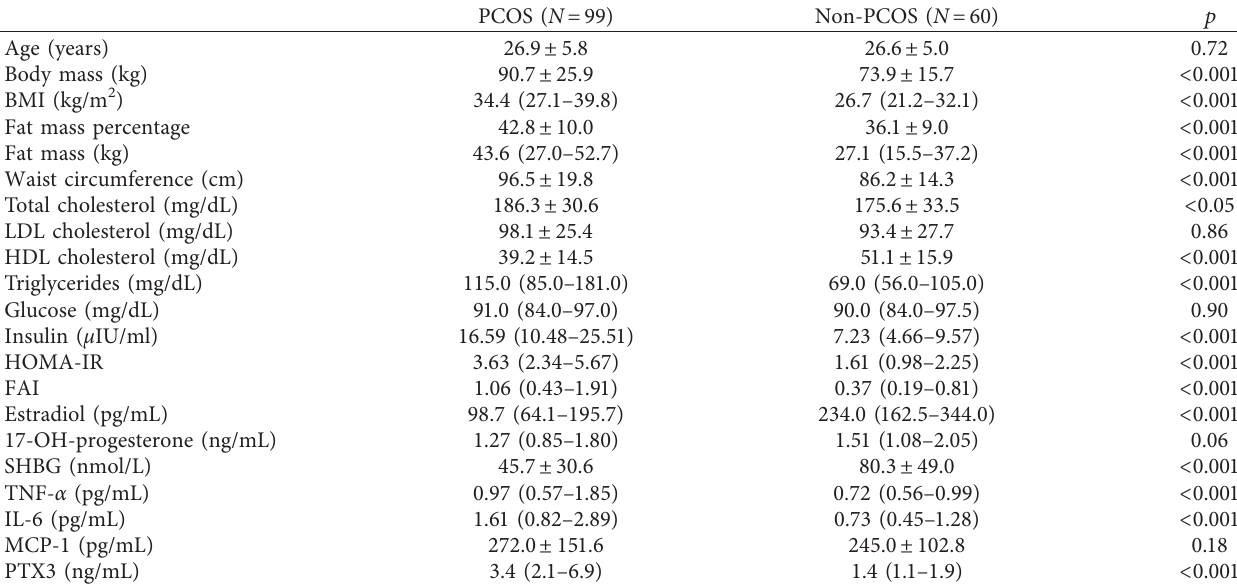
Table 1: Baseline characteristics and comparison between PCOS and non-PCOS group.